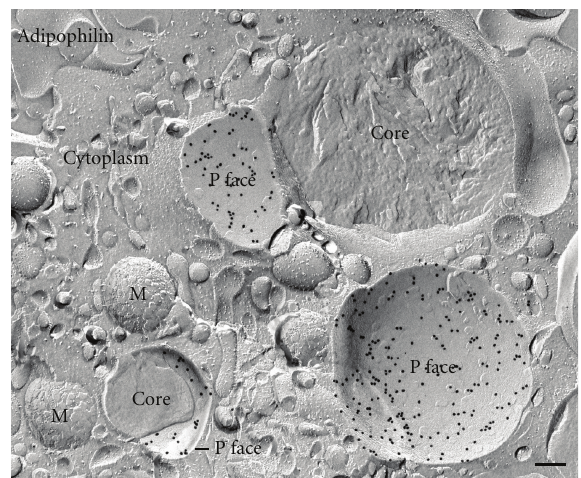
Figure 4: Survey freeze-fracture view of a lipid-laden macrophage immunogold-labeled for adipophilin. Prominent label is seen in the outer phospholipid monolayer (P face) of the lipid droplets. M: mitochondria. Bar: 0.2 μ